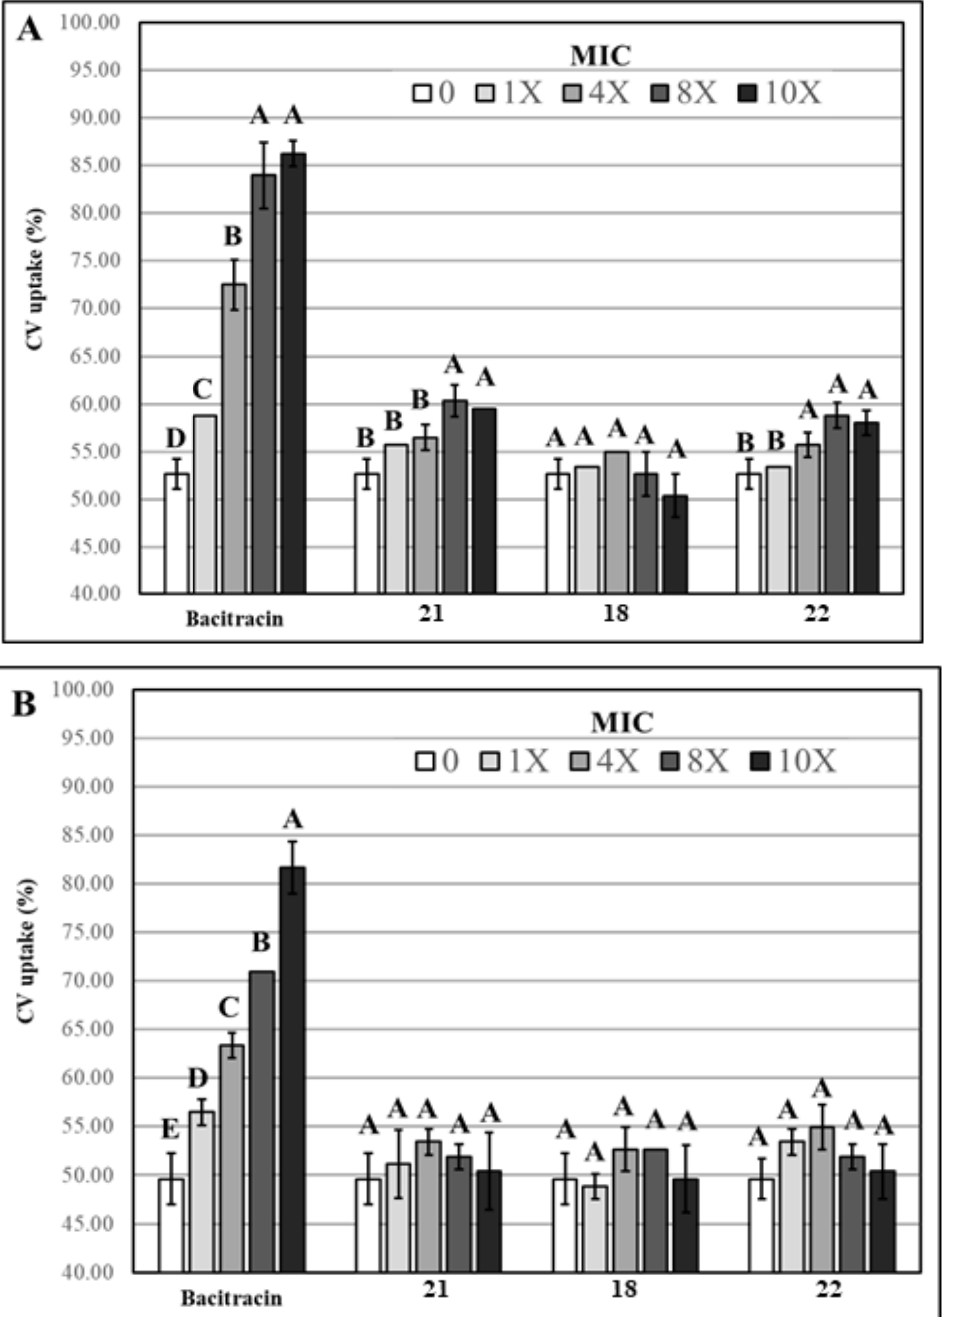
Figure 3. Crystal Violet (CV) uptake assay. The percentage (%) of CV uptake from S. aureus ATCC 6538P ( A ) and E. faecalis ATCC 29,212 cells ( B ), either untreated (0) or treated with bacitracin, 21 , 18 and 22 at 1X, 4X, 8X, 10X MIC for 1 h at 37 °C. Bars represent the means ± standard deviation. Different superscript letters A–E indicate average values significantly different ( p < 0.05) according to post hoc Tukey test.